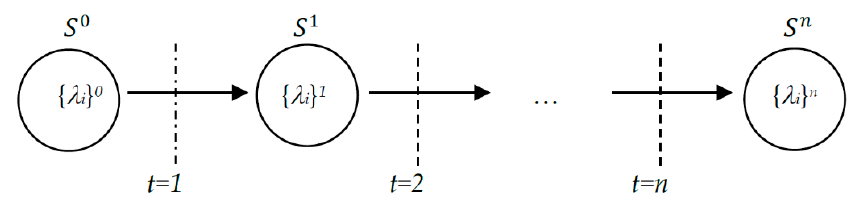
Figure 2. {𝜆 (cid:3036) } transition over time. Figure 2. { λ